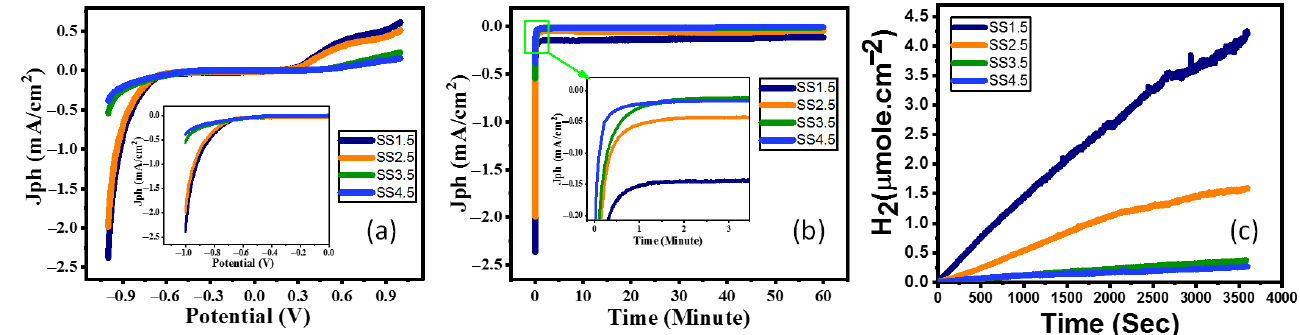
Figure 4. ( a ) Variation in current density vs. applied voltage for all photocathodes in standard white-light luminance, ( b ) variation in current density vs. exposure time for all photocathode @ − 1 V current density, and ( c ) number of hydrogen moles versus production time for all photocathodes in white-light luminance.